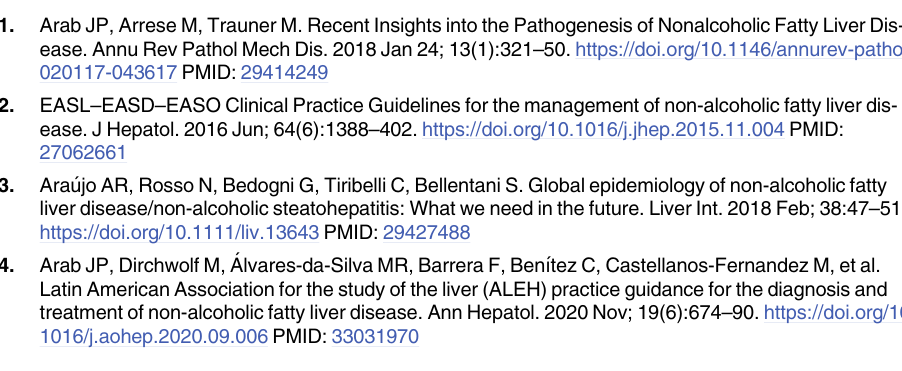
S19 Fig. Effect of exercise alone on IHL by supervision. (TIF) S20 Fig. Effect of exercise alone on ALT levels by supervision. (TIF) S21 Fig. Effect of exercise alone on HOMA-IR by supervision. (TIF) S22 Fig. Effect of exercise alone on AST by supervision.